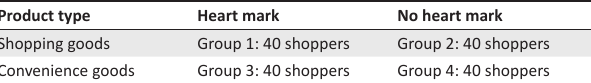
TABLE 1: Depiction of the respondent group. Product